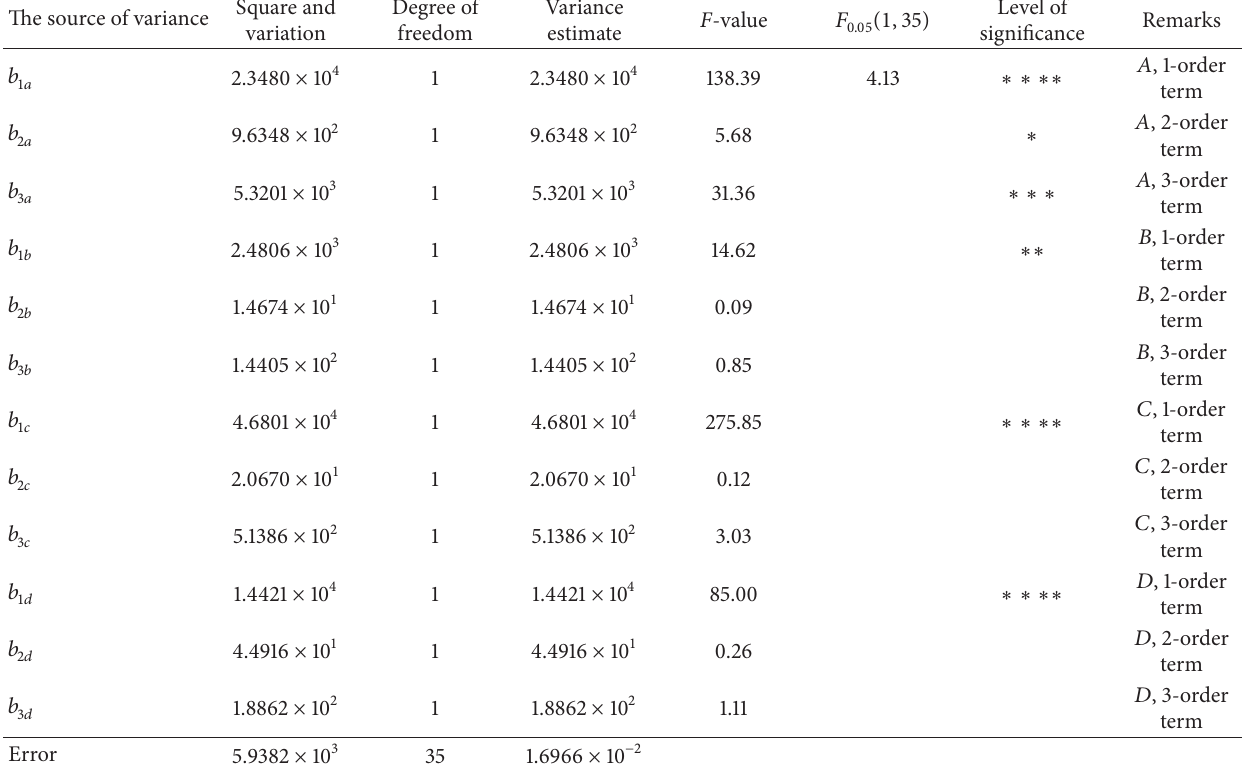
Table 6: Orthogonal polynomial regression analysis of variance: Young’s modulus